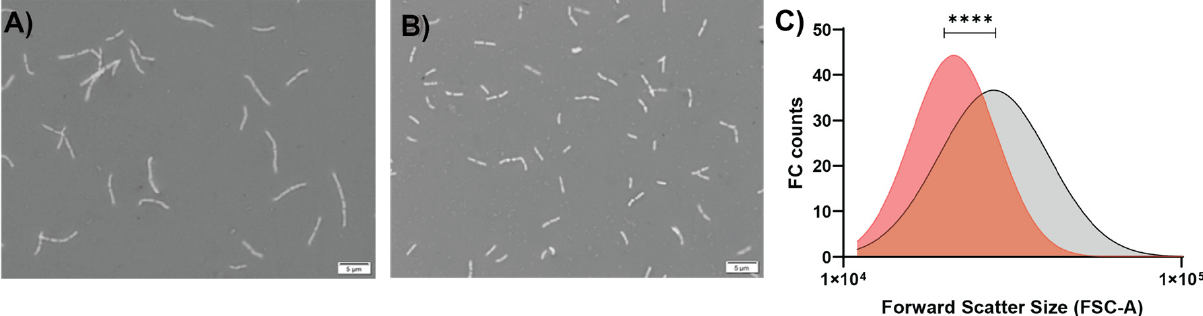
Figure 2. Confocal microscopic pictures of cells of B. longum NCC 2705 grown in DasGip bioreactors with 1% of glucose ( A ) or 1% of galactose ( B ). Panel ( C ) shows the cell size of both cultures (galactose in red, glucose in grey) represented by the forward scatter signal obtained by flow cytometry. Statistical analyses were performed using Welch- t test (**** p < 0.0001) on modeled population distri- butions.